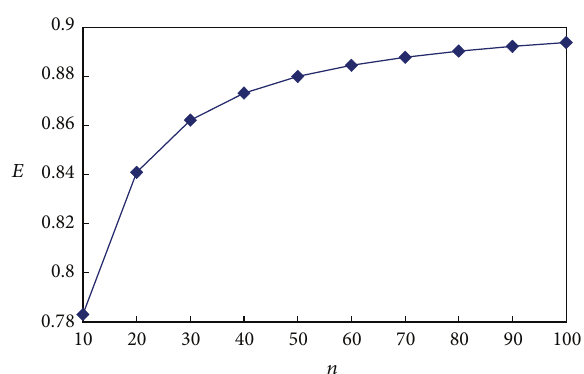
Figure 9: Efficiency of the dynamic routing mechanism.